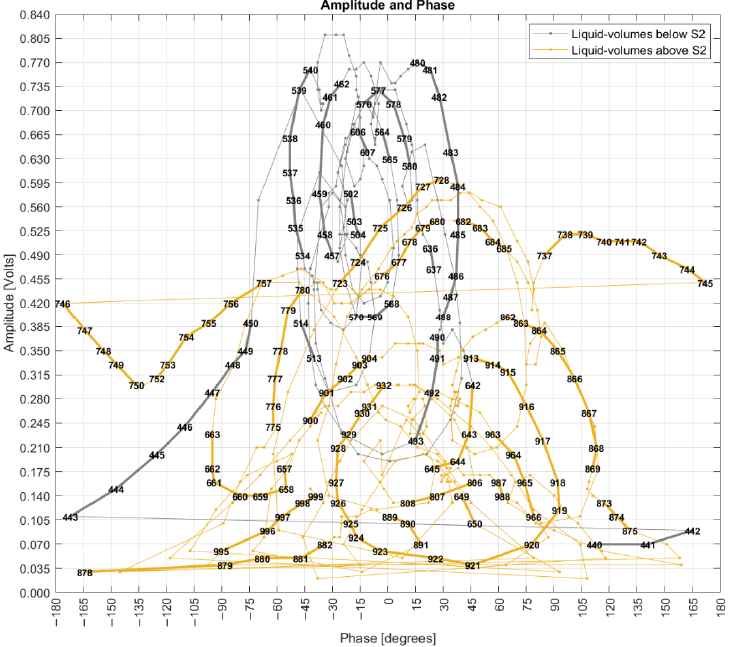
Figure 16. The 2D grade of amplitudes and corrected phases (only action “a” applied).